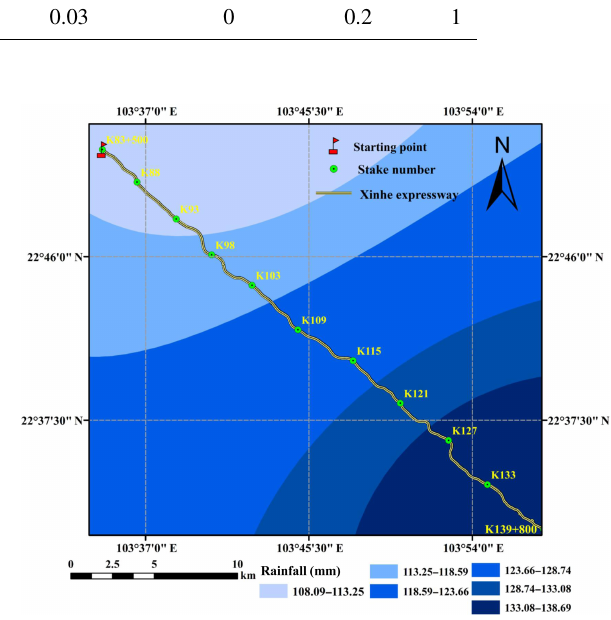
Figure 13. Rainfall interpolation results under a 20-year return pe-